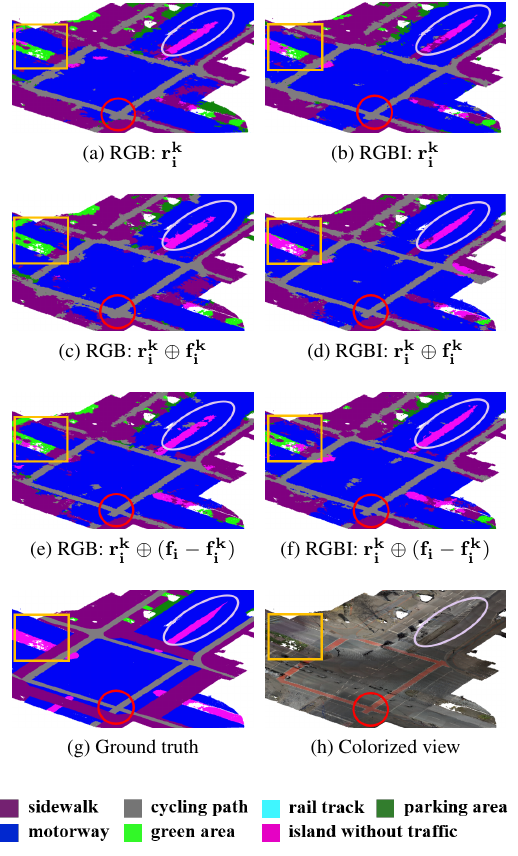
Figure 5. Comparison of road type classification results using different feature combinations to weigh the neighboring points. Holes in the dataset are caused by the removal of cars in pre-processing. Rectangles, ellipses, and circles highlight the differences between results with different feature combinations and the ground